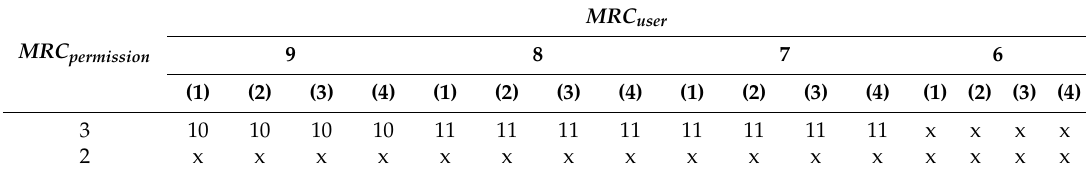
Table 22. The number of optimized roles in